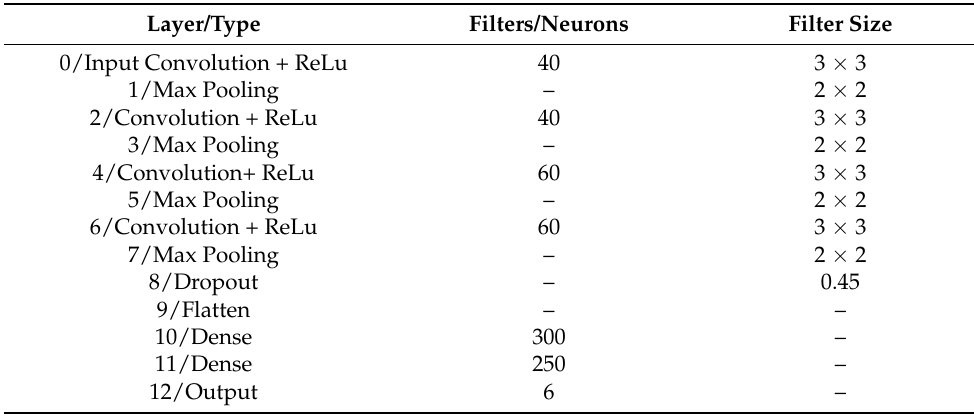
Figure 9. Output MF for the Fuzzy MG. Table 4. Proposed